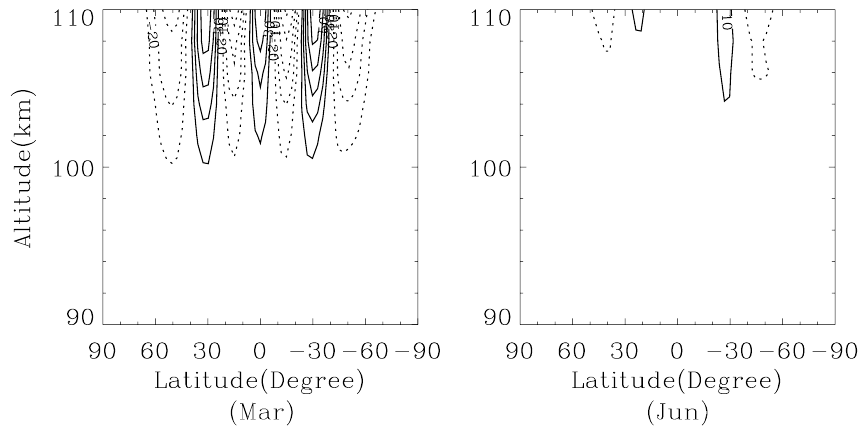
Fig. 6. Same as Fig. 5 but for background temperature alterations for March (left) and June (right). The intervals of the contours are 10K. The solid and dotted curves denote the positive and negative values,